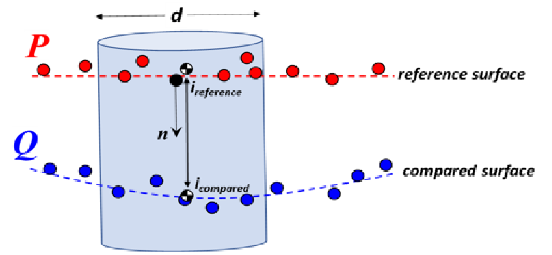
Figure 6. Execution of M3C2